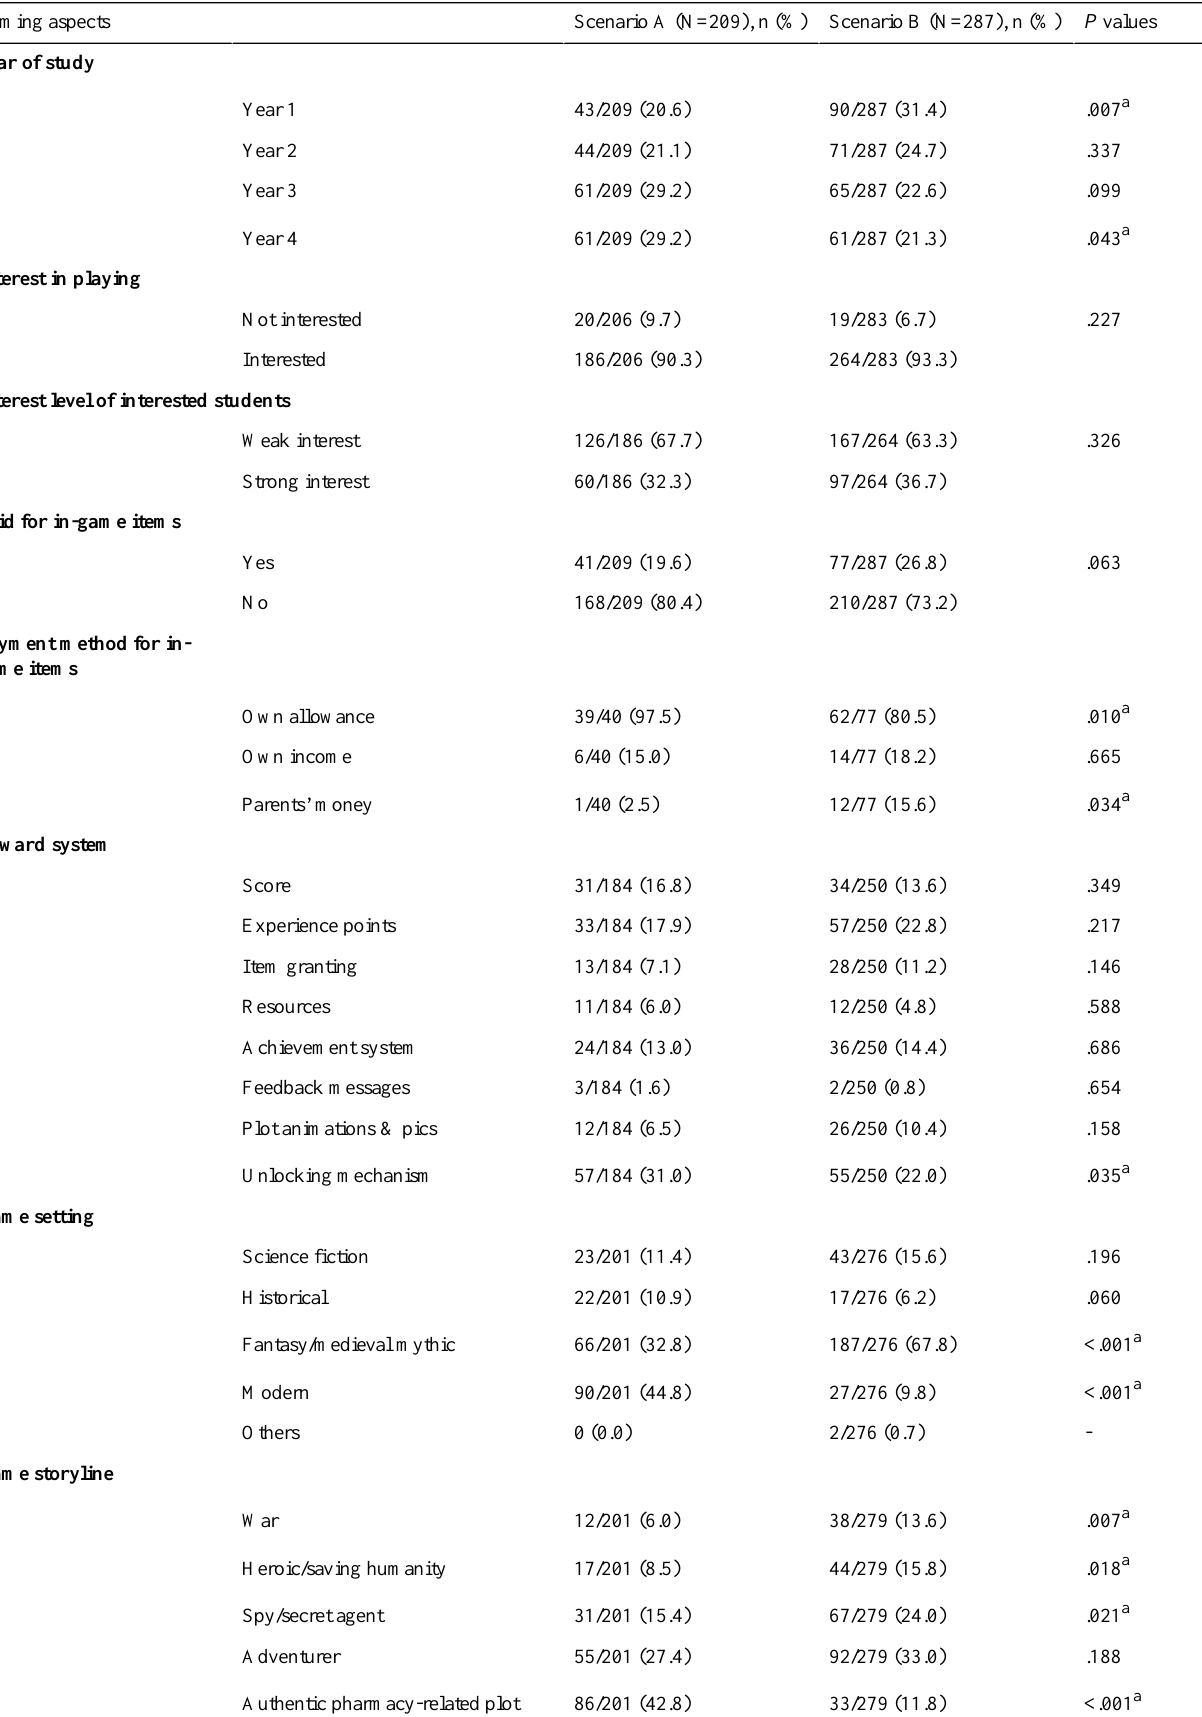
Table 4. Comparison of gaming aspects by game scenario choice in the pharmacy-related serious